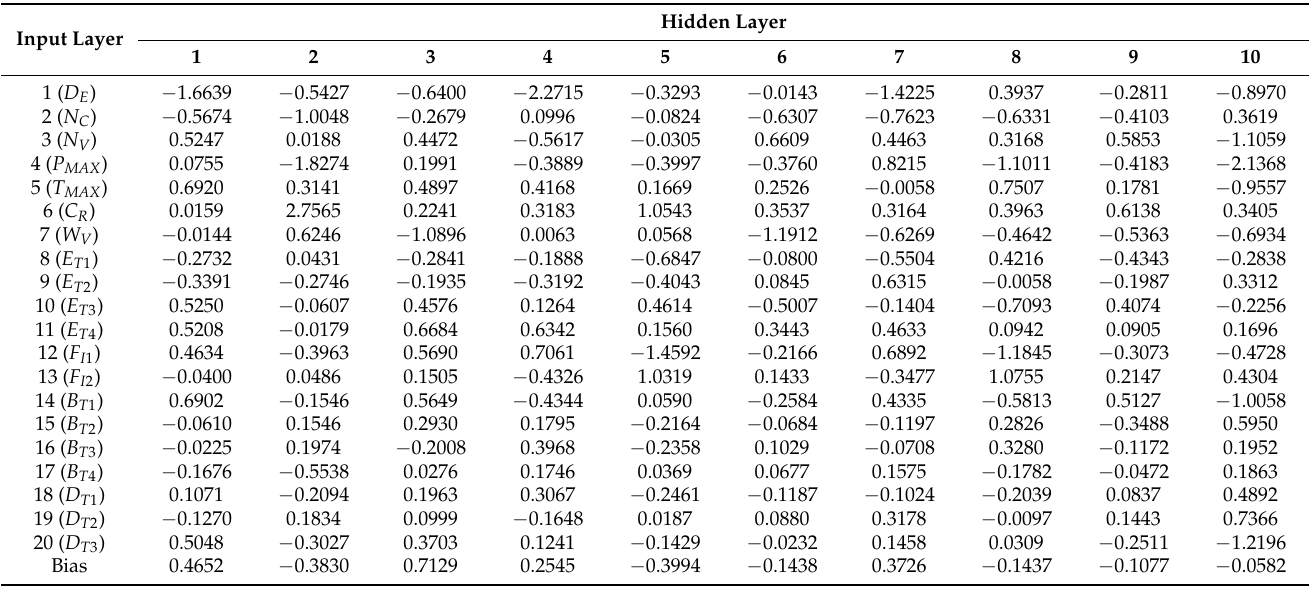
Table A3. Weights between the input layer and hidden layer in the MLP 20-10-3 artificial neural